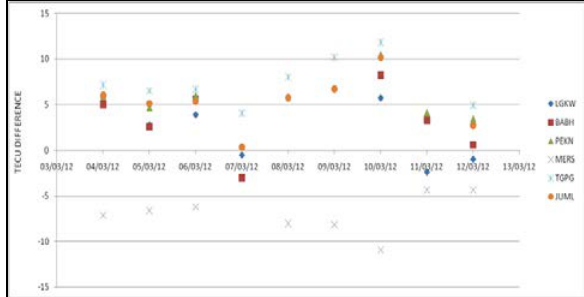
Figure 7. TEC value difference between GPS_TEC and Bernese